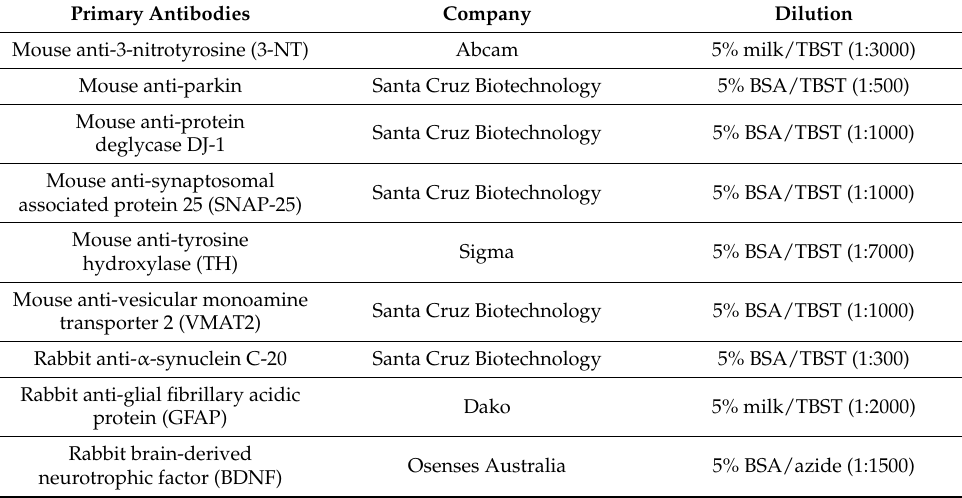
Figure A2. Western blot detection of precursor brain-derived neurotrophic factor (pro-BDNF) and mature brain-derived neurotrophic factor (mBDNF) in the striatum. Table A1. Antibodies used for Western blotting in this study.